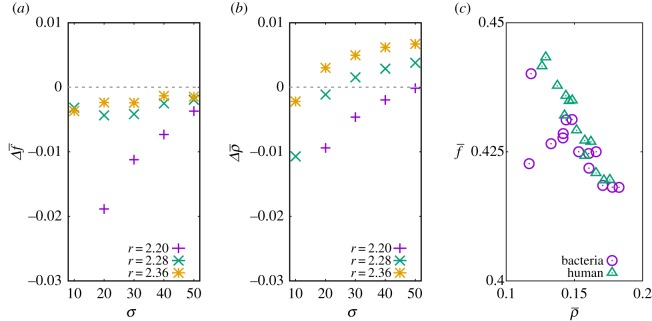
The difference of average quantities in dotted and striped patterns. For patterns used in figure 4, we try to figure out the distinct properties of dotted and striped patterns. The differences of average quantities Δ f¯ and Δρ¯ get from the average quantity of dotted and striped patterns. The negative Δ f¯(Δρ¯) indicates the higher f¯(ρ¯) of the striped patterns than the dotted patterns.